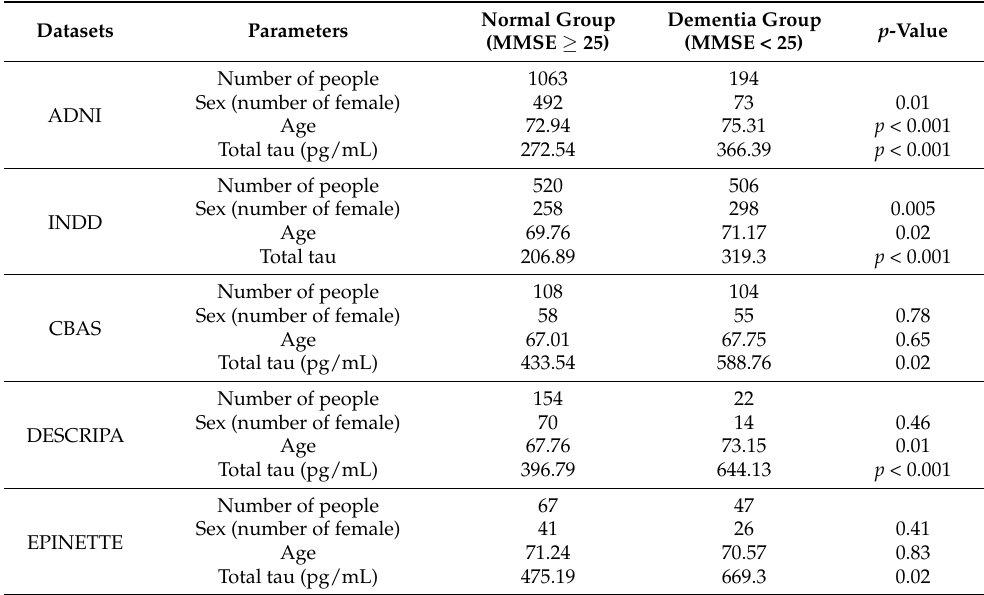
Table 2. Difference of CSF total tau level between dementia patients and healthy people in all 5 datasets. p -Values < 0.05 indicate that the difference is significant.